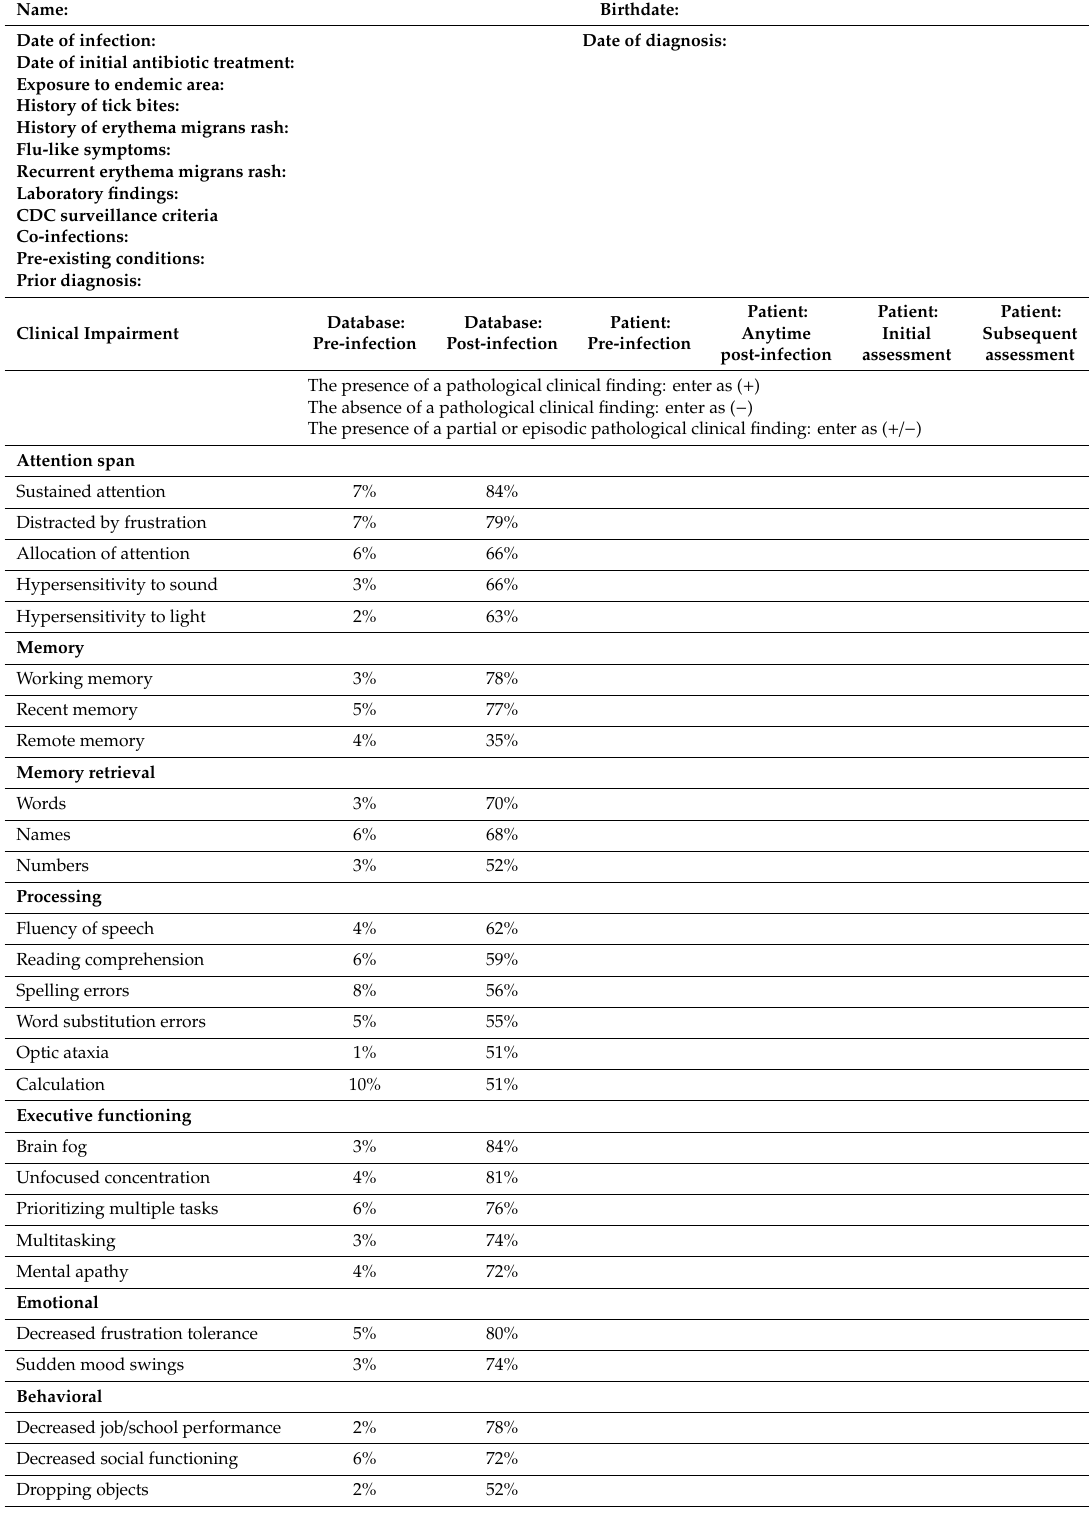
Table 5. Common symptom assessment in which ≥ 50% or more have the clinical